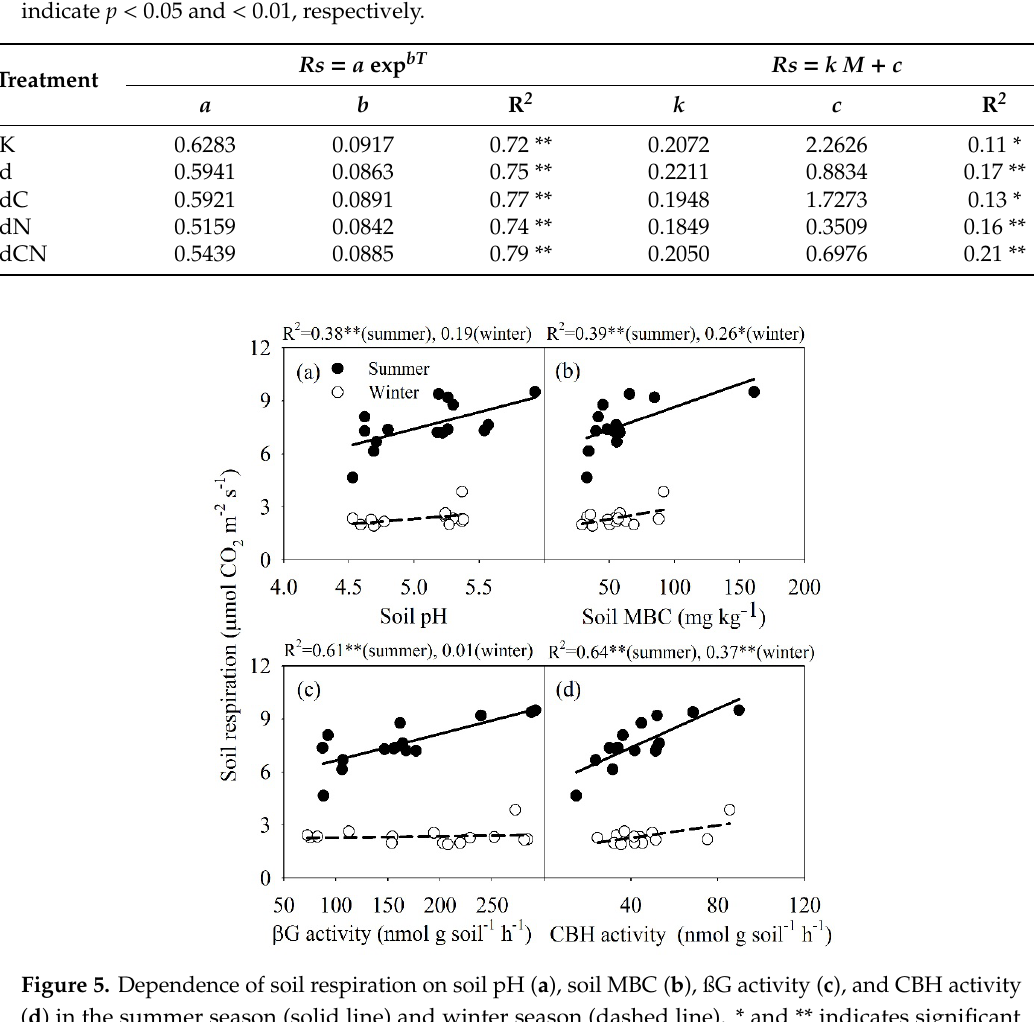
Table 3. Regression models for the relationships of soil respiration ( Rs ) with soil temperature ( T ) and soil moisture ( M ) among the five treatments. The five treatments individually referred to as CK (the